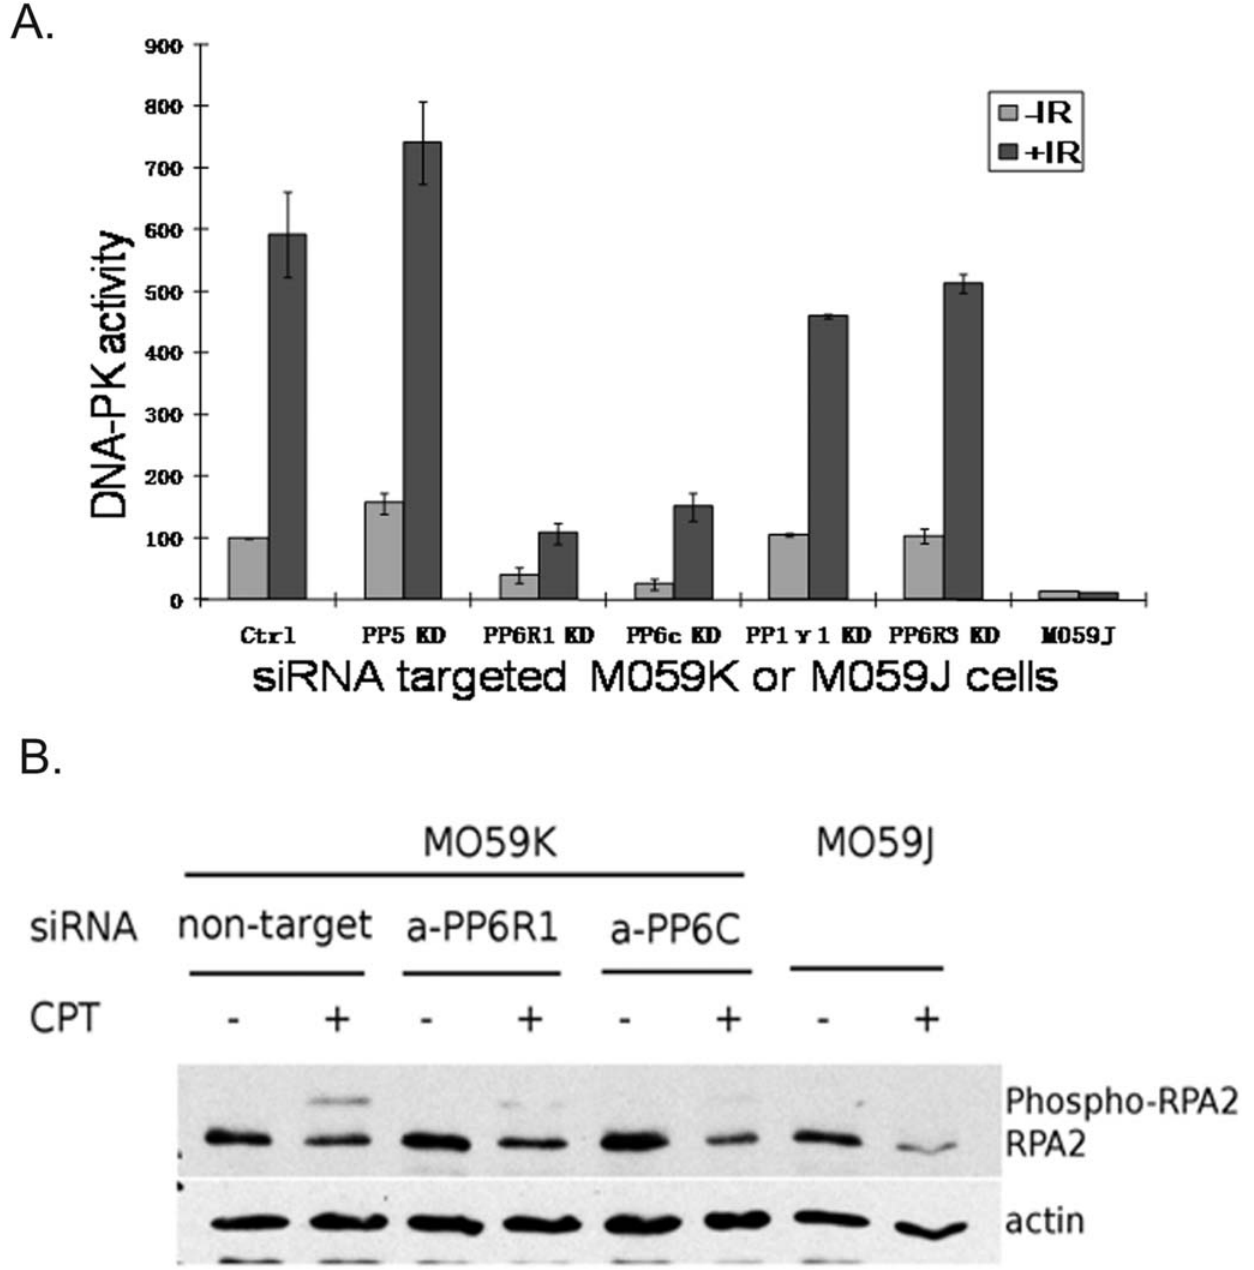
Figure 4. siRNA knockdown of PP6R1 significantly decreases DNA-PK kinase activity. M059K cells were transfected with control, non- targeting siRNA or specific siRNAs targeted to PP5, PP1 c 1, PP6c, PP6R3 and PP6R1. A. Forty-eight hours after transfection, the M059K cells were irradiated with 5 Gy or sham-irradiated. Thirty minutes after irradiation, cells were harvested and fractionated. DNA-PKcs was immunoprecipitated from nuclear fractions, and the activity of DNA-PKcs was measured by incorporation of 32 P into a DNA-PKcs-specific P53-derived peptide substrate. DNA-PKcs-deficient M059J cells were used as a negative control. The numbers were normalized to non-irradiated M059K cells and the data show the mean of counts per minute per m g protein in the eluted solution 6 SD (n=3). B. M059K cells transfected with anti-PP6c or anti-PP6R1 siRNA as described in panel A were treated with 1 m M CPT for 4 hours. RPA2 was detected in whole cell lysates by Western blot. . The slower migrating band represents the phosphorylated form of RPA2. M059J cells were used as a negative